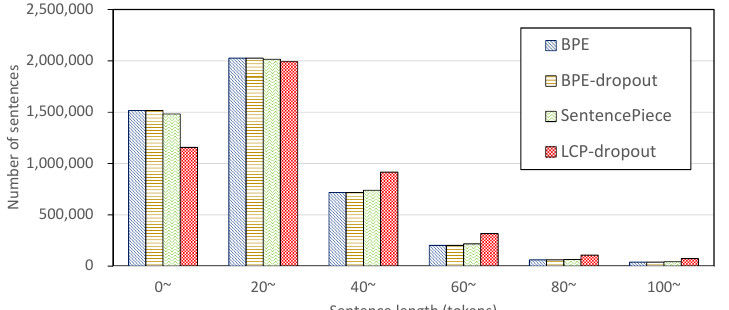
Figure 2. Distribution of sentence length. The number of tokens in each sentence by LCP-dropout tends to be larger than the others: BPE, BPE-dropout, and